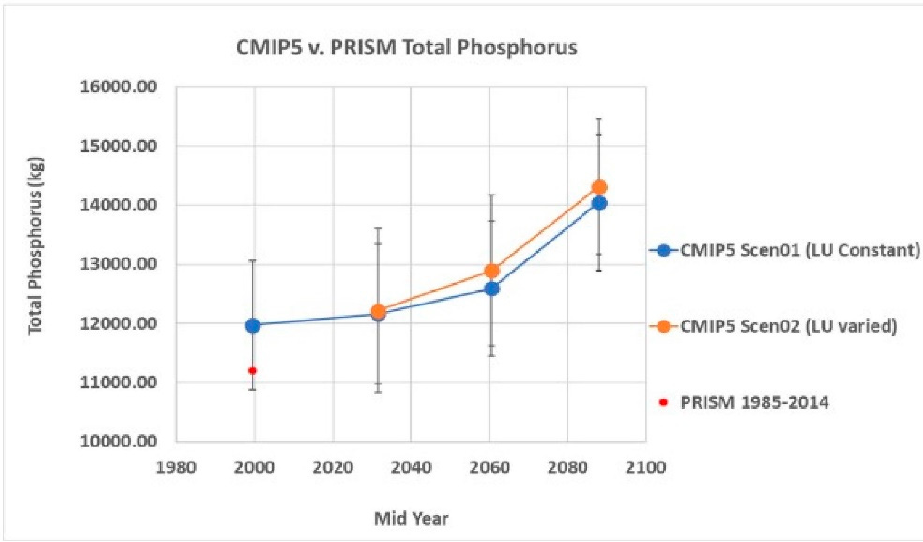
Figure 13. PRISM vs. average of 20 CMIP5 GCMs total phosphorus (2018–2100).